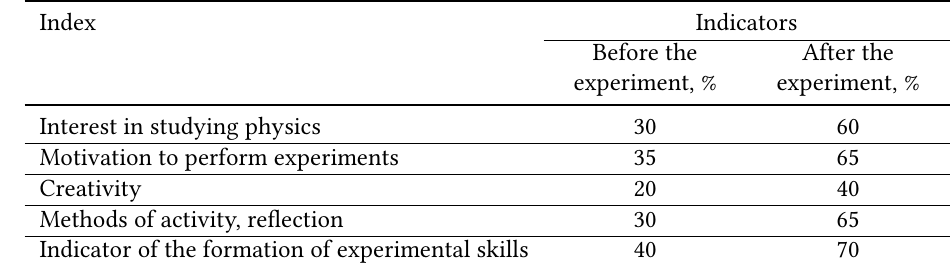
Table 1 The results of the formation of experimental skills of students of the experimental